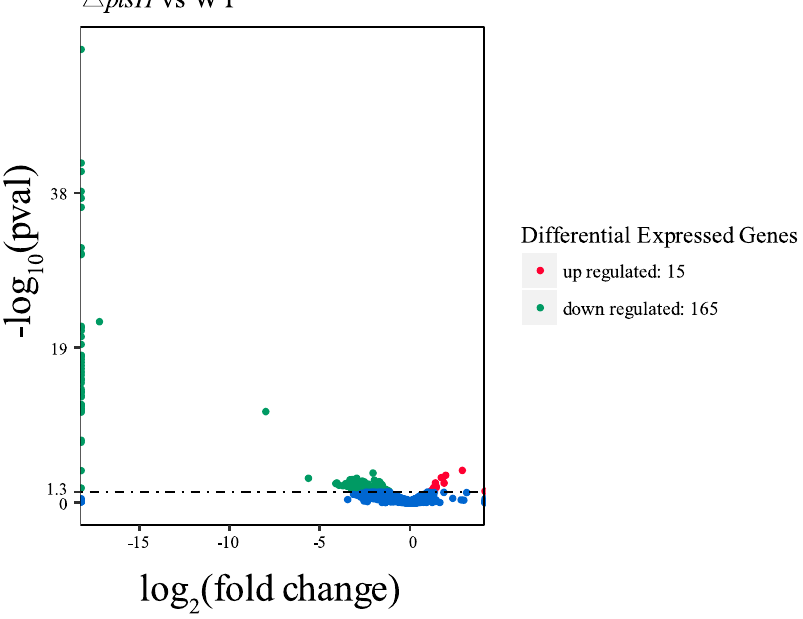
Figure 8. Volcano map of differentially expressed genes between the WT strain and the ∆ ptsH mutant. Red dots represent the upregulated genes, green dots represent the downregulated genes, and blue dots represent the genes with no significant differential expression.